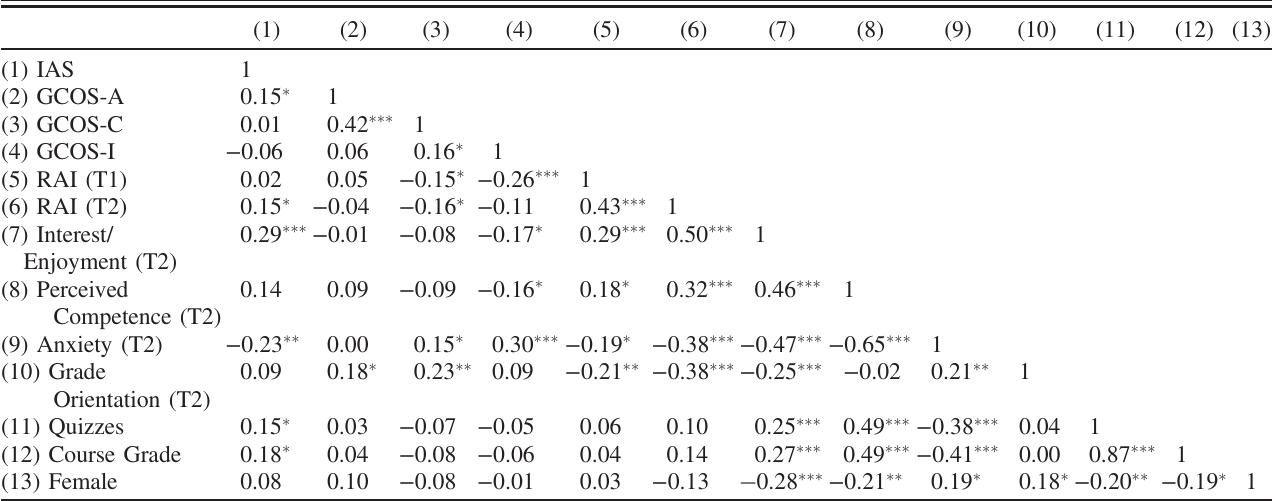
TABLE III. Pairwise correlation matrix ( N ¼ 182 ) showing the standardized correlation coefficients ( β ’ s) of key variables with accompanying p values, where (cid:2) p < 0 . 05 , (cid:2)(cid:2) p < 0 . 01 , (cid:2)(cid:2)(cid:2) p < 0 . 001 .